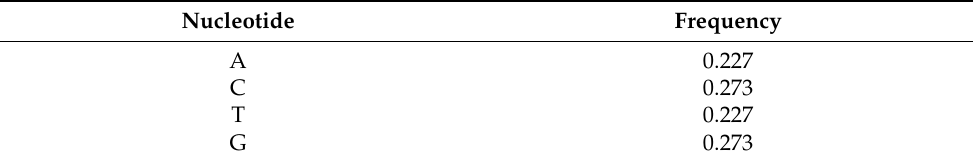
Table 2. Frequencies of purines and pyrimidines in 23S gene